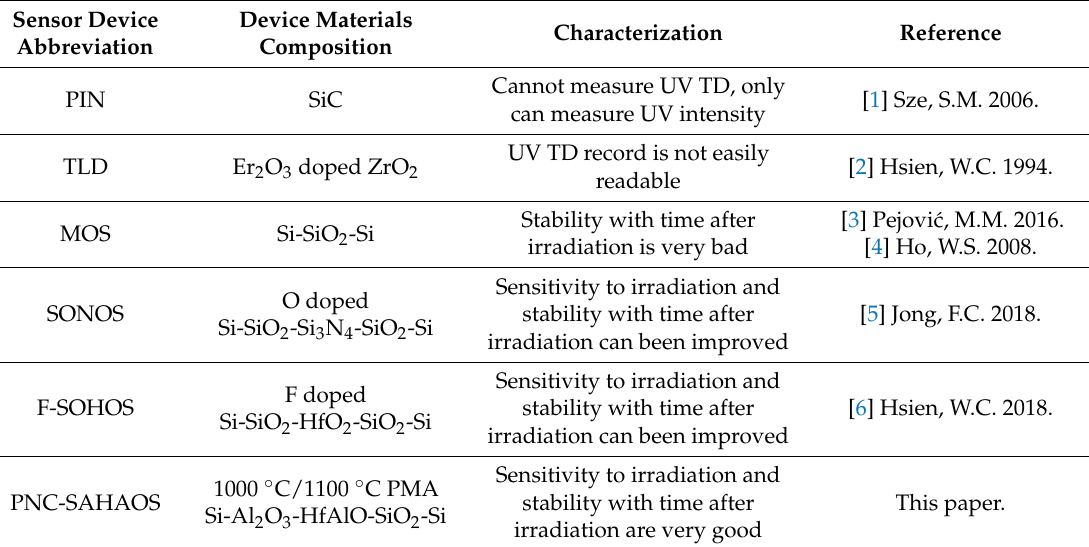
Table 1. Comparison of UV